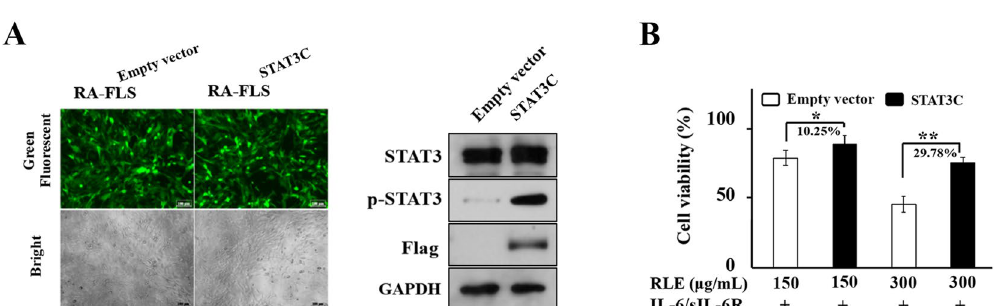
Figure 6. Over-activation of STAT3 diminished the anti-proliferative effect of RLE in RA-FLS. ( A ) Green fluorescent protein (GFP) expression, and protein levels of p-STAT3 (Tyr 705), STAT3 and Flag in RA-FLS Empty vector and RA-FLS STAT3C . RA-FLS were transduced with empty vector or Flag-tagged STAT3C plasmid with GFP as a transduction indicator. Cells expressing GFP displayed green fluorescence. Representative green fluorescent and bright-field microscopy images of RA-FLS Empty vector and RA-FLS STAT3C are shown in the left panel. Scale bar: 100 μm. Protein levels of p-STAT3 (Tyr 705), STAT3 and Flag were determined using immunoblotting. Representative immunoblots are shown in the right panel. ( B ) Over- activation of STAT3 diminished the anti-proliferative effect of RLE in IL-6/sIL-6R-stimulated RA-FLS. Cells were transduced with Ad-Empty vector (RA-FLS Empty vector ) or Ad-STAT3C (RA-FLS STAT3C ). Cell viability was assessed using CCK-8 assays (n = 3). Differences of relative viabilities between RLE-treated RA-FLS Empty vector and RLE-treated RA-FLS STAT3C were calculated. * P < 0.05, ** P <